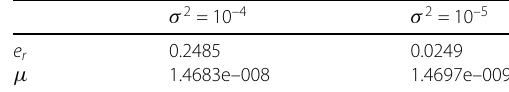
Table 2 Numerical results of the example for different σ 2 with α =